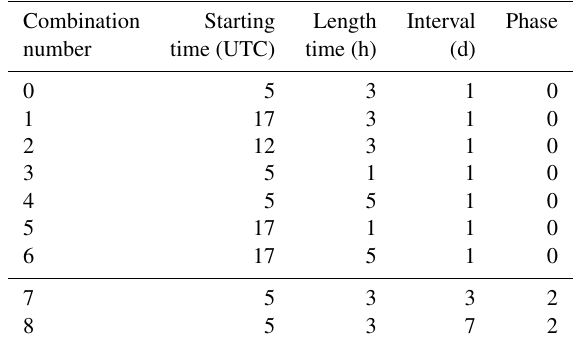
Table 2. Table of number indexes used, e.g., CHAN4 is channel method fourth combination of the table